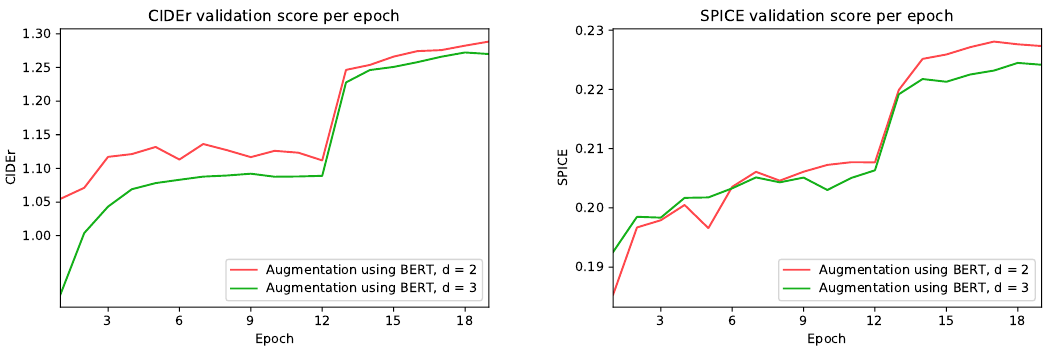
Figure 3. Validation scores per epochs during a training phase oon a dataset with BERT augmentation with d = 2 and d = 5.